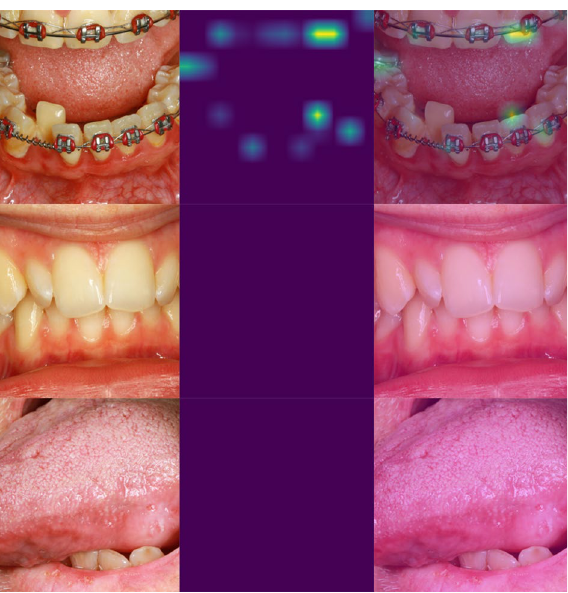
Figure 5. Class activation map for normal mucosa. The left column shows the CP of normal mucosa. The middle column represents the class activation map. The right column illustrates the overlay of CP and activation